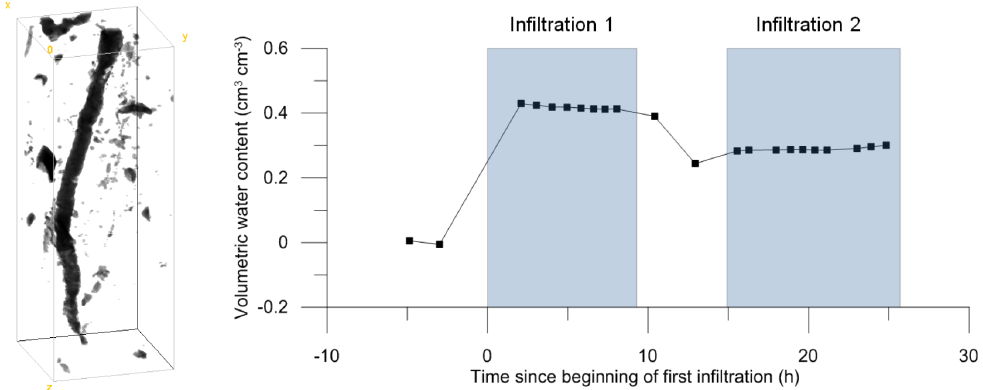
Figure 11. Macropore system that represents 1.97% of the sample volume segmented from X-ray tomogram (left). Time sequence of water contents in the macropore system derived from series of 22 tomograms (right). The blue columns indicate the time of two ponding infiltration